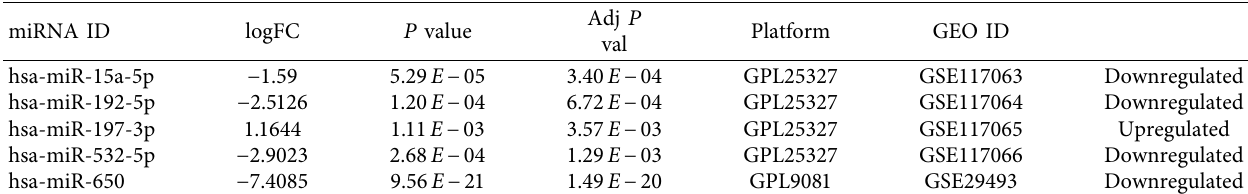
Figure 7: Te miRNA-mRNA regulatory network of miR-15a-5p, miR-147a, miR-192-5p, miR-197-3p, miR-532-5p, miR-650, and the targeted genes participating in NF-kappa B signaling pathway. Rectangle nodes represent miRNAs, and oval nodes represent mRNAs. Table 1: Information of screened miRNAs in GEO